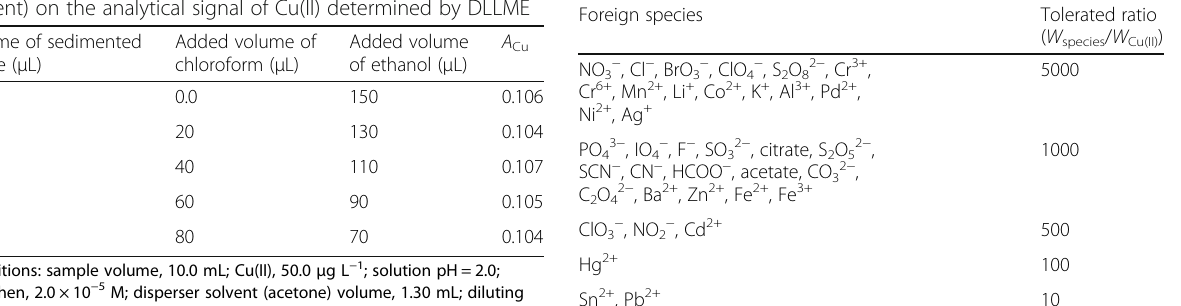
Table 3 Tolerance limits for interferences in determination